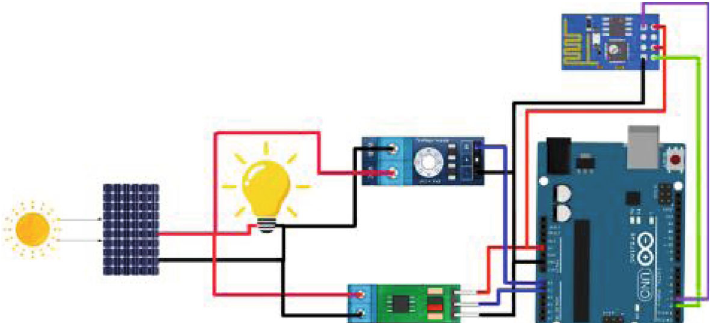
Figure 6: Circuit diagram of datalogger.